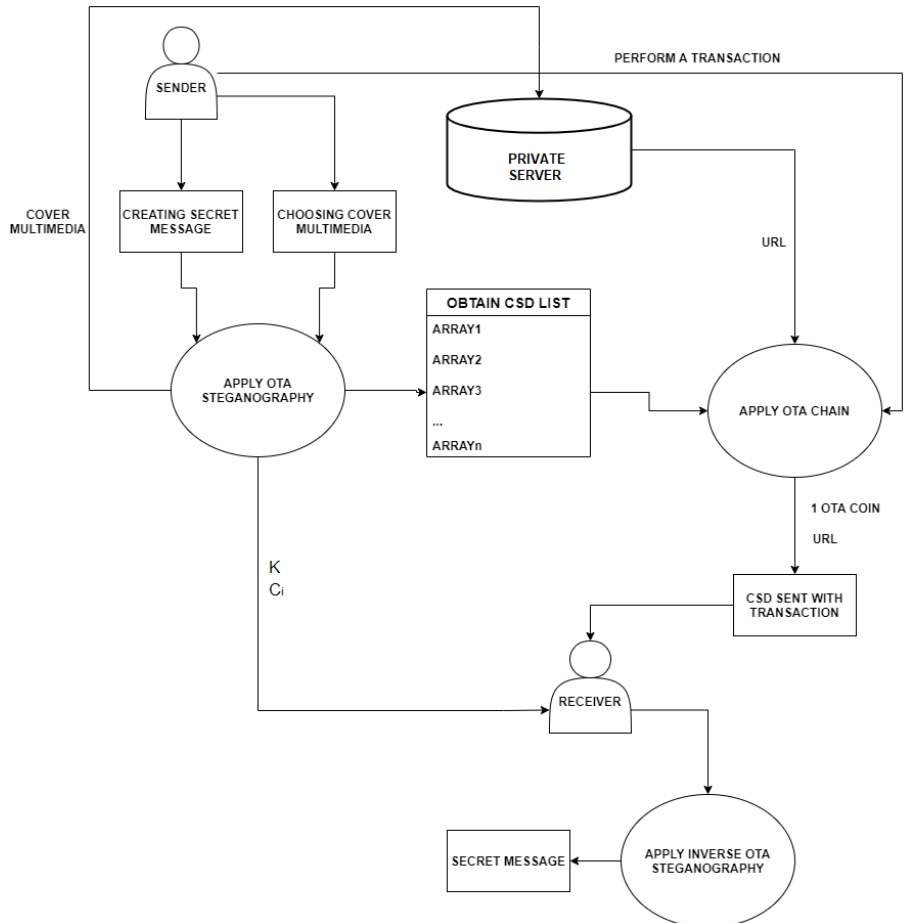
Figure 4. Structure of OTA Algorithm.